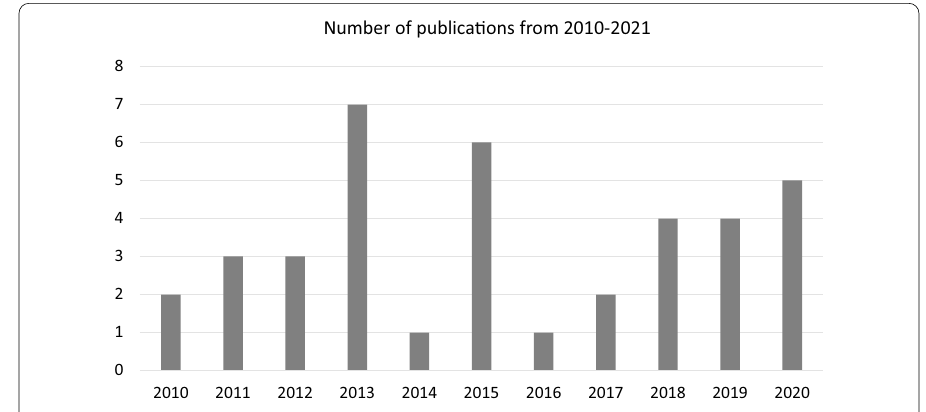
Fig. 4 Number of publications from 2010 to 2021